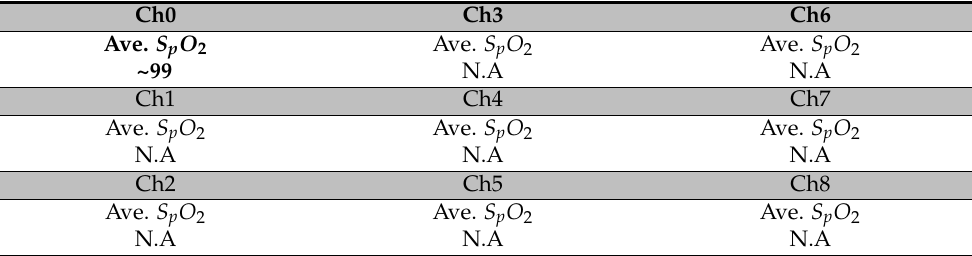
Table 7. The calculated blood oxygen concentration of the array sensors using the design with a sensor spacing of 7